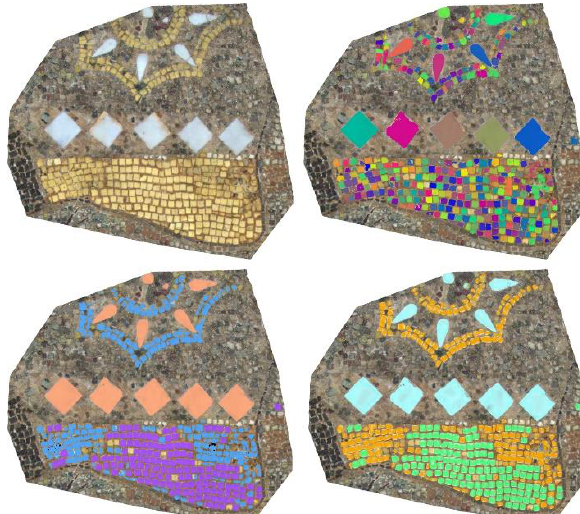
Figure 13 Zone 1: Classification of tesserae. From left to right, Colour, abstraction-based segmented, classified, 2D outline In the second zone containing 12 821 752 points, 313 gold tesserae (195 NG and 118 AG) and 269 silver tesserae (ST) were processed. 284 (91%) golden tesserae were correctly segmented, of which 93% were correctly labelled NG and 95% AG, and 93% of ST were correctly segmented, of which 87% were correctly labelled. The third larger sample composed of 34 022 617 points includes 945 gold tesserae and 695 CG (coloured glass) tainted in black. The other tesserae in the sample had an insufficient resolution for ground truth generation. 839 (89%) golden tesserae were correctly segmented, of which 86% were correctly labelled NG and 95% AG. Concerning CG, (494) 71% were correctly segmented, and 98% were correctly labelled. While classification results are very high, segmentation is heavily influenced by the